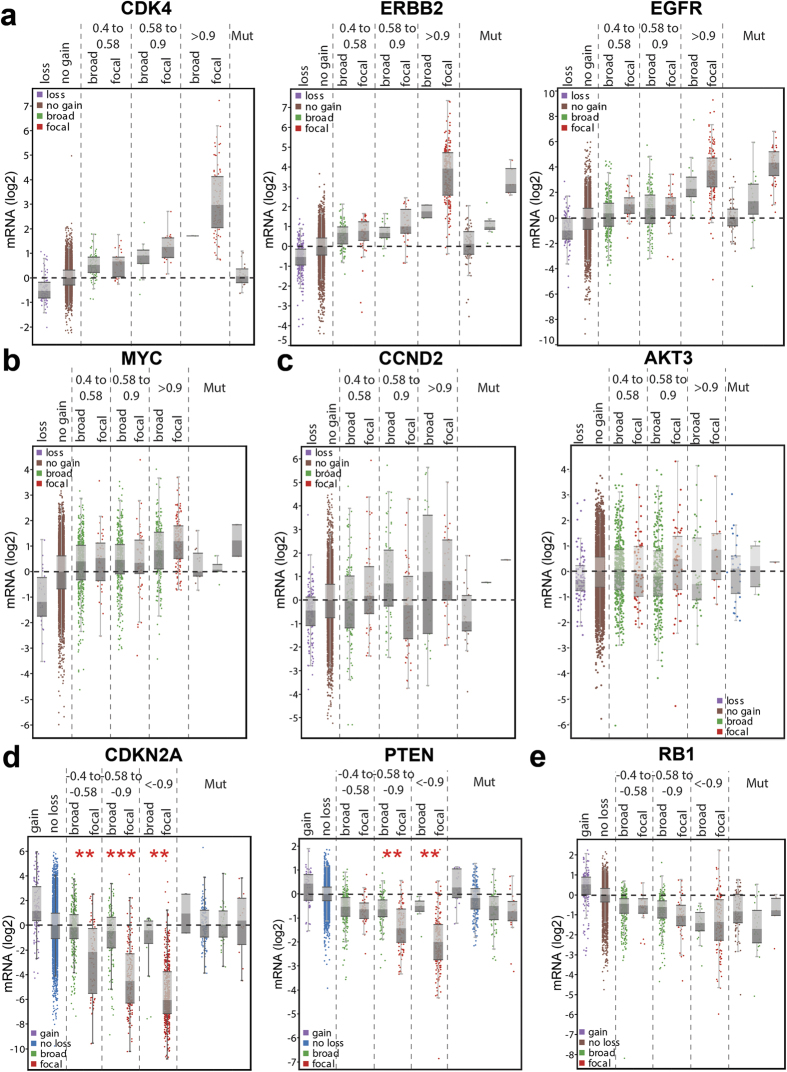
Known oncogenes and tumor suppressors display variability in correlations of expression to SCNA copy number amplitude and length.Log2 expression values (y-axis) normalized within cancer types versus binned amplitude values (x-axis) for: (a) three representative oncogenes whose high-expressing samples are well predicted by SCNA amplitude, (b) MYC, (c) two representative peri-telomeric genes with low predictive scores, (d) two tumor suppressors whose low-expressing samples are well predicted by SCNA amplitude and length together, and (e) a representative tumor suppressor with low predictive scores. *p < 0.05, **p < 0.01, ***p < 0.001 for broad vs focal within each bin. For each gene, any sample with non-synonymous mutations were separated out into their own group (“Mut”) to avoid the influence of mutations on CN-expression correlations.